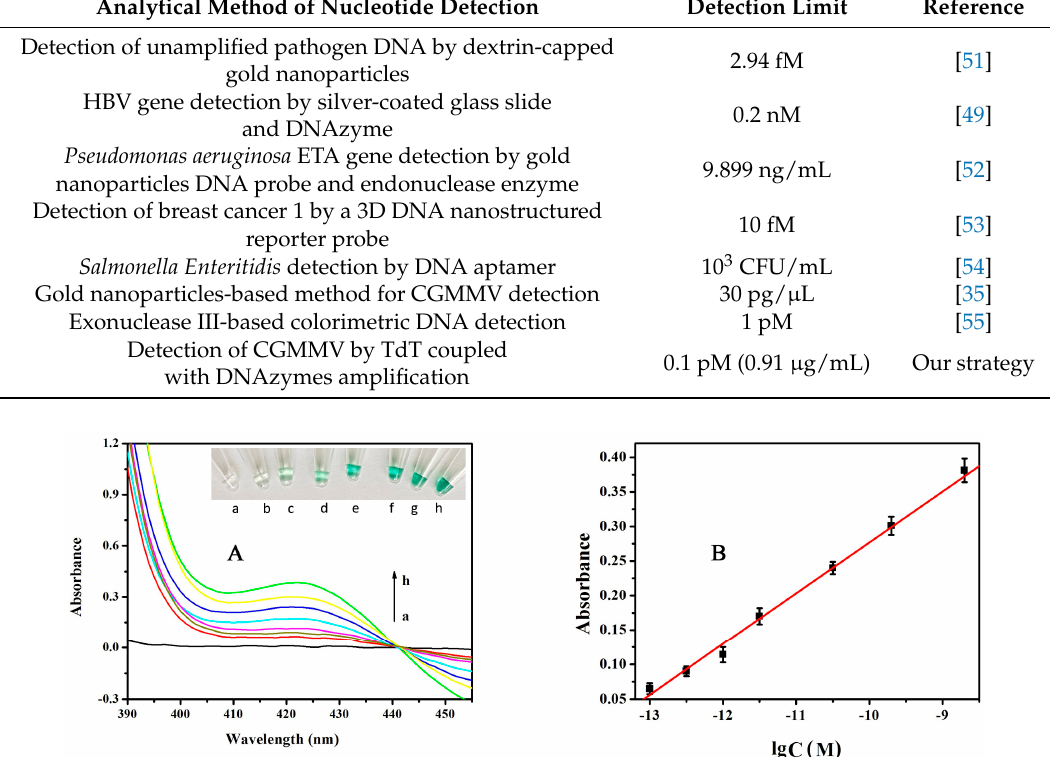
Figure 3. ( A ) Absorbance with various concentrations of T1. The arrow from a to h represents the concentrations of 0 pM, 0.1 pM, 0.25 pM, 1 pM, 2.5 pM, 25 pM, 0.2 nM, and 2 nM. The insert is the image of the color detection of the corresponding concentration of T1. ( B ) The linear correlation between the absorbance and the logarithm of the concentration of T1 (M).